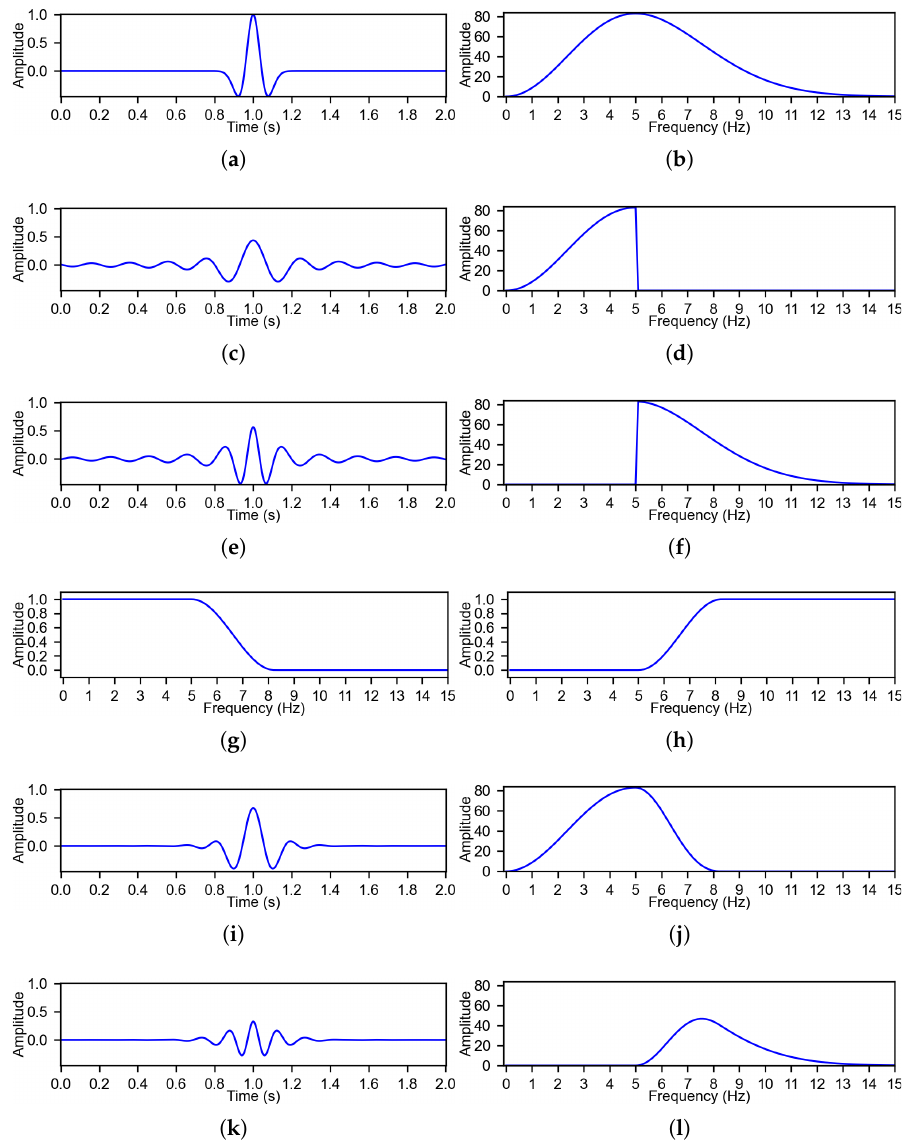
Figure 2. Splitting the low- and high-frequency data (single trace 1D view). ( a ) 5-Hz Ricker wavelet. ( b ) Fourier amplitude spectrum of ( a ). ( c ) Corresponding LF (<5 Hz) data in the time domain, i.e., inverse fast Fourier transform (IFFT) of the LF data in ( d ). ( d ) Low-frequency (<5 Hz) amplitude spectrum of ( b ). ( e ) Corresponding HF ( (cid:62) 5 Hz) data in the time domain, i.e., IFFT of the HF data in ( f ). ( f ) High-frequency ( (cid:62) 5 Hz) amplitude spectrum of ( b ). ( g ) Designed LF window for suppressing the Gibbs effect shown in ( d ). ( h ) Designed HF window for suppressing the Gibbs effect shown in ( f ). ( i ) Corresponding LF data in the time domain, i.e., IFFT of the LF data in ( j ). ( j ) Windowed LF amplitude spectrum of ( d ). ( k ) Corresponding HF data in the time domain, i.e., IFFT of the HF data in ( l ). ( l ) Windowed HF amplitude spectrum of ( f ). Note that the Gibbs effect shown in panels ( c , e ) is successfully suppressed in panels ( i , k ) by the designed splitting window shown in panels ( g , h